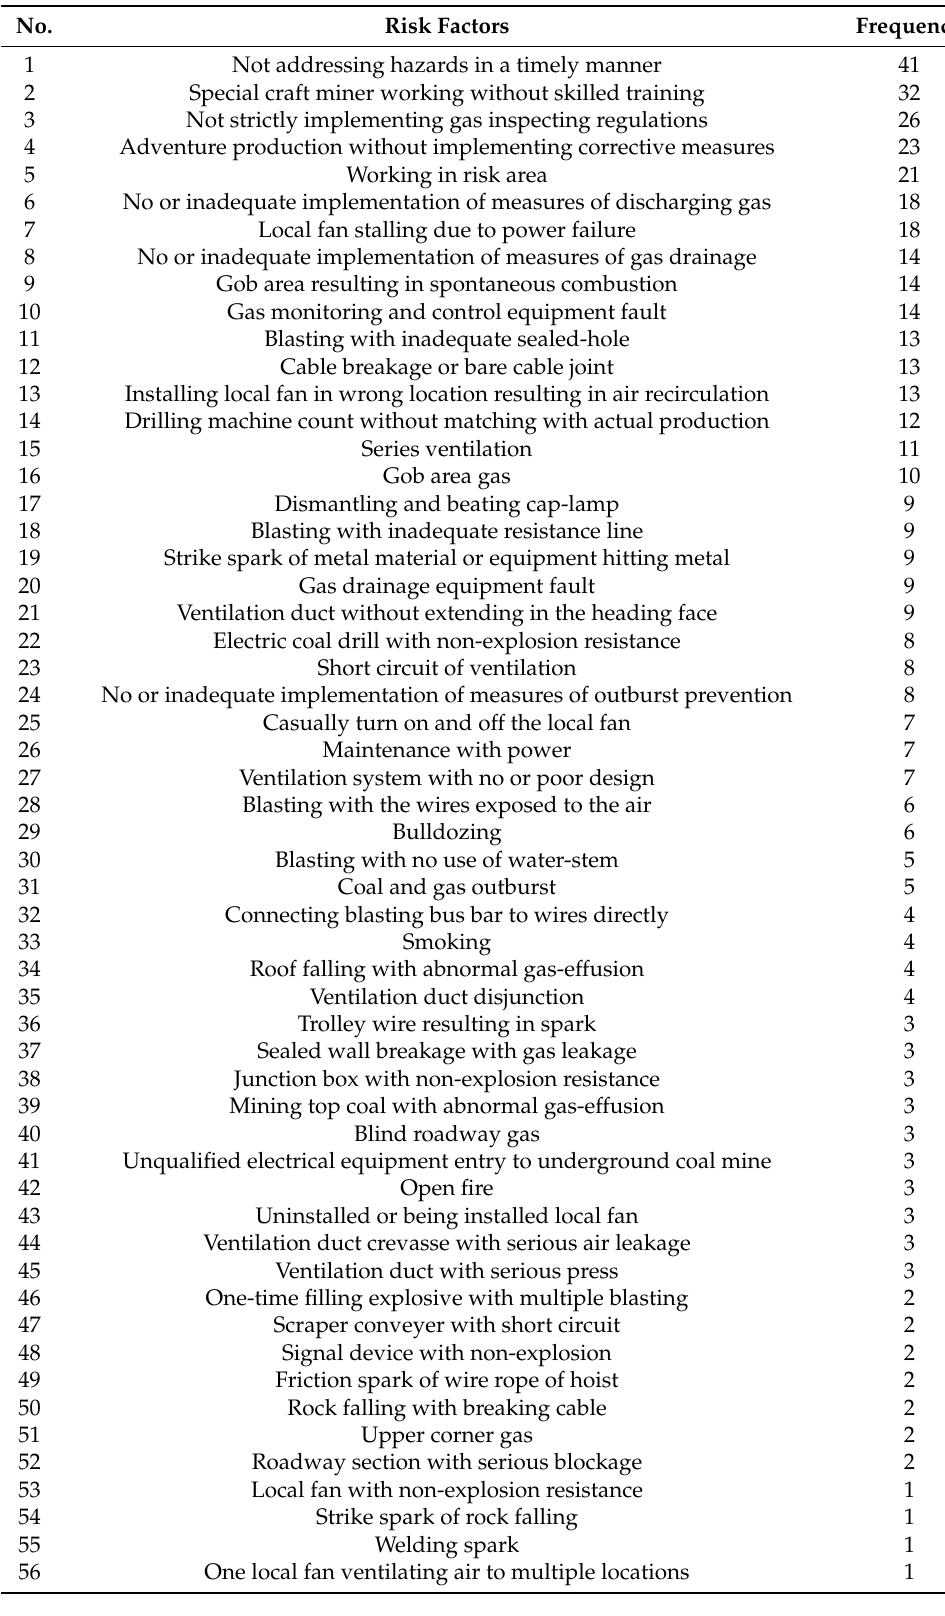
Table 2. The comprehensive risk factors based on 128 cases